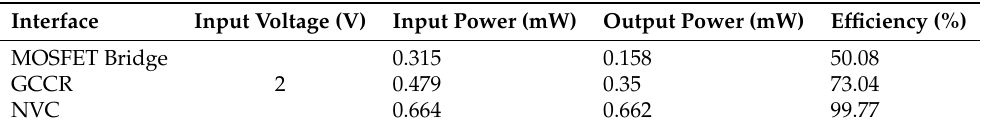
Table 1. Influence of the rectifier type on the performance of State of the Art P-SSHI for resistive loads [28].